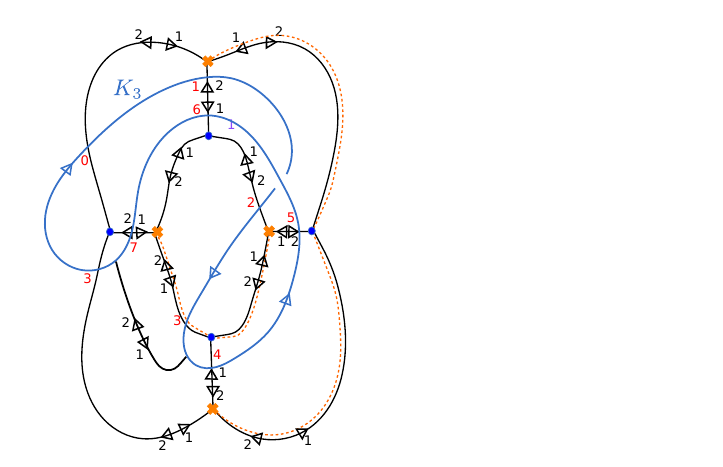
Figure 43 . Lifts corresponding to framed BPS states in the charge sector 2 (cid:13) 1 (cid:0) (cid:13) 2 + (cid:22) 1 + (cid:22) 3 (cid:0) 2 (cid:22) 4 and their contributions to F ([ K 2 ]).